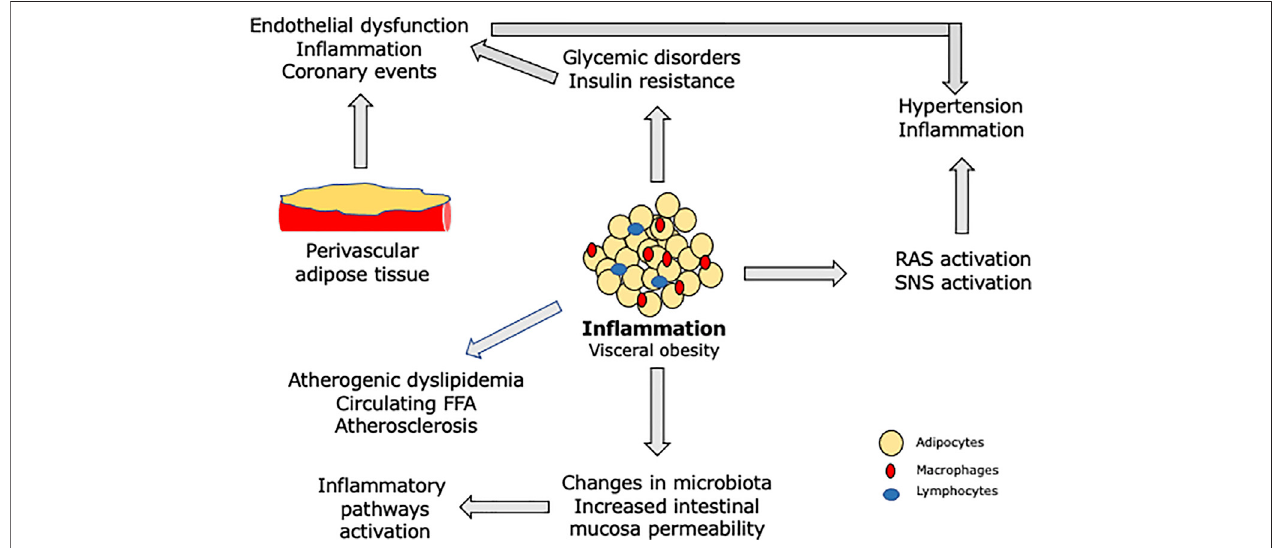
FIGURE1| Pivotalroleofin fl ammation inpatients withmetabolic syndrome. RAS — renin angiotensin system; SNS — sympatheticnervoussystem;FFA — freefatty acids. Perivascular adipose tissue causes endothelial dysfunction and local in fl ammation, contributing for atherosclerotic plaque complications. Changes in microbiota composition and higher permeability of the intestinal mucosa to bacterial products such as lipopolysaccharides activate in fl ammatory pathways. Macrophages and lymphocytes in fi ltrate visceral adipose tissue and release proin fl ammatory cytokines, which are related to insulin resistance. These cytokines and FFA change cell signaling related to insulin causing endothelial dysfunction, insulin resistance, and cardiovascular remodeling. The systemic in fl ammatory status is also related to increased thrombotic risk, leading to ischemic events.